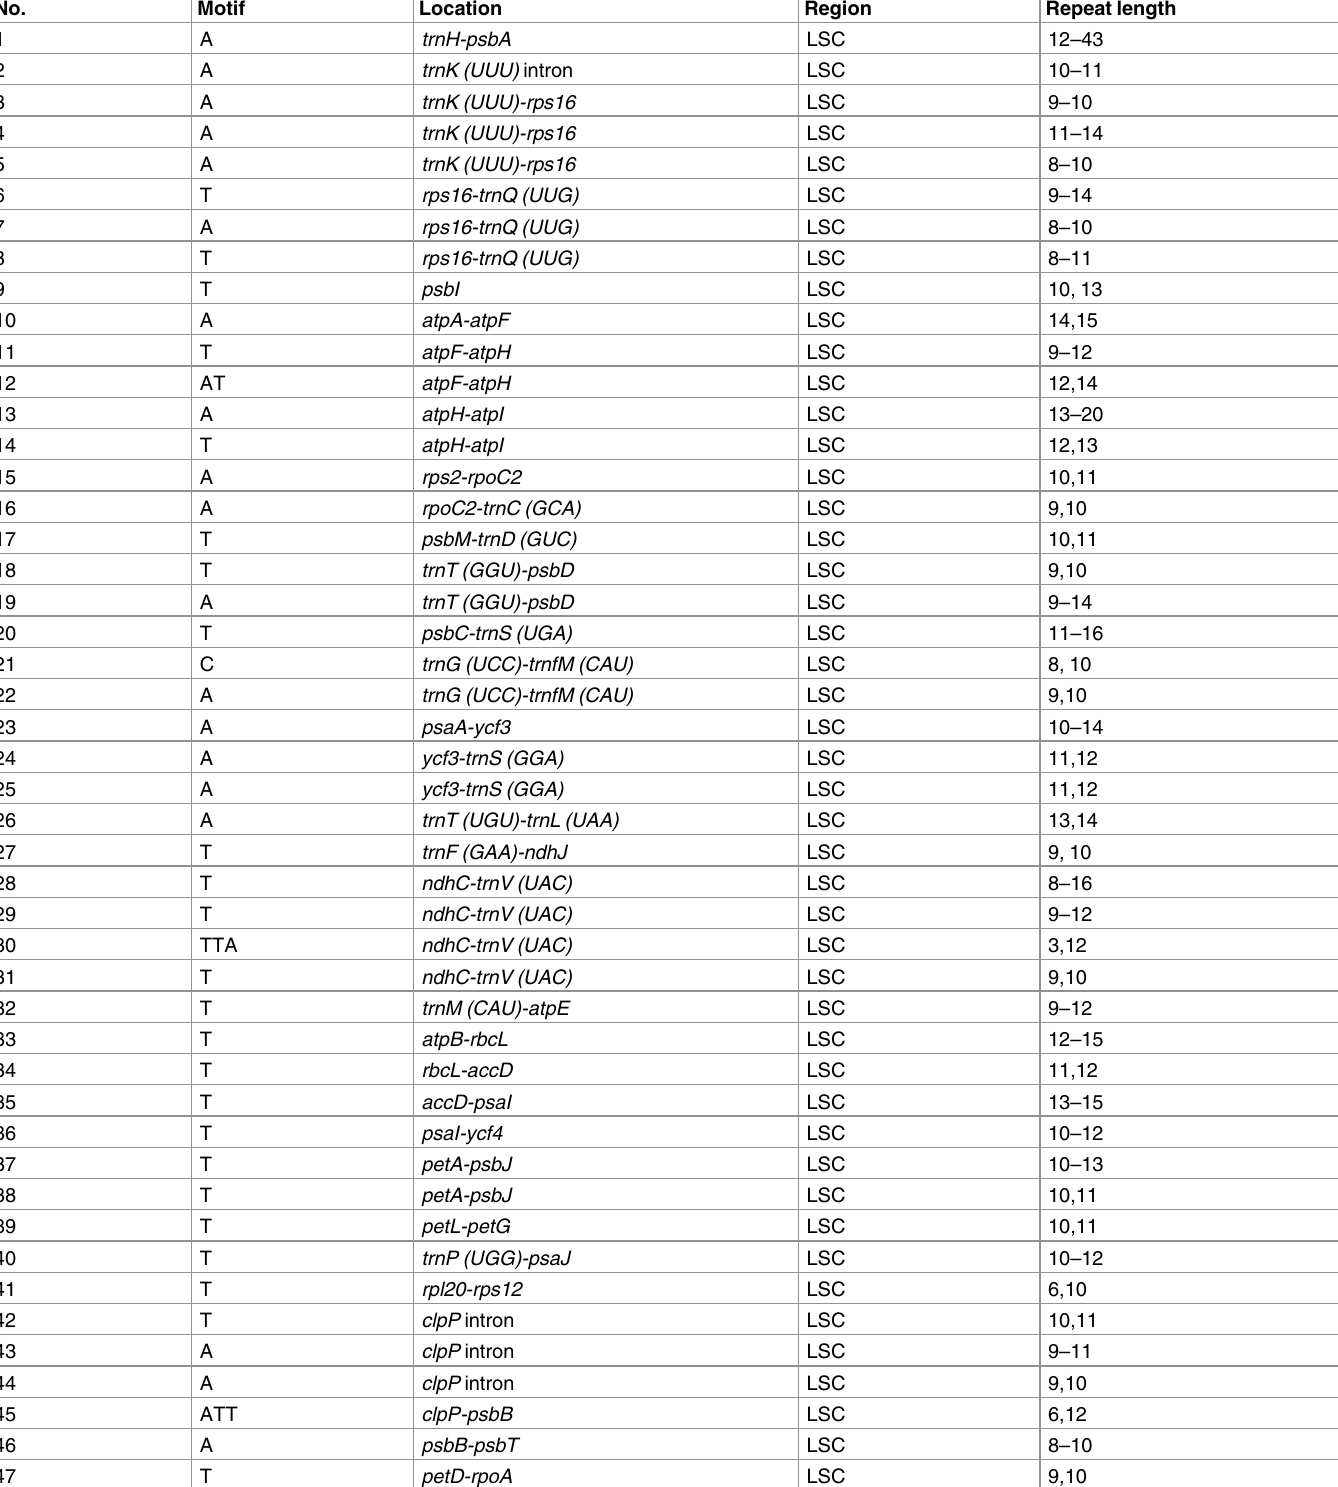
Table 4. Location of SSR loci within the 11 Schima